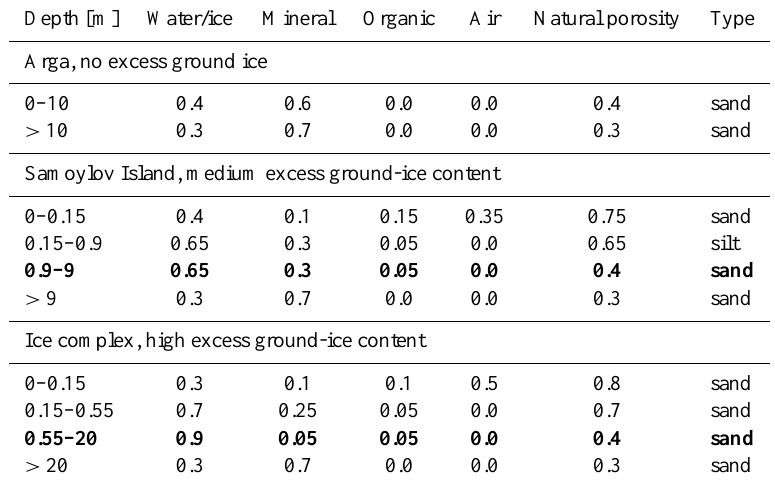
Table 2. Sediment stratigraphies of the long-term susceptibility runs, with volumetric fractions of the soil constituents and soil type for each layer given. Layers super-saturated with ice in bold.